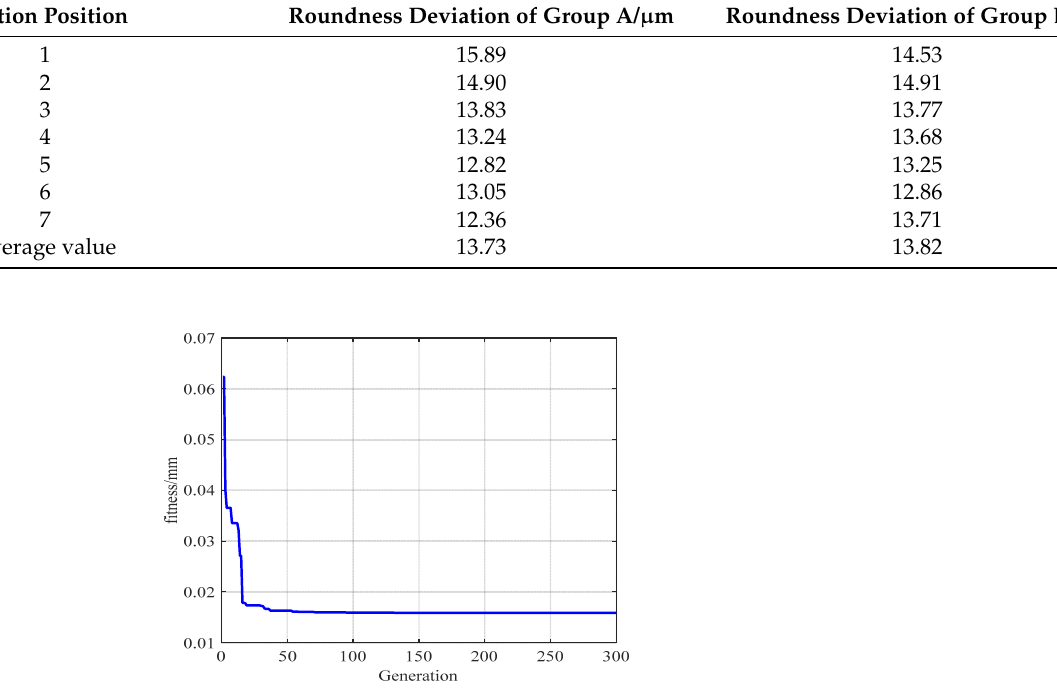
Figure 19. Graph of the improved PSO calculation results for position 1 in group A.